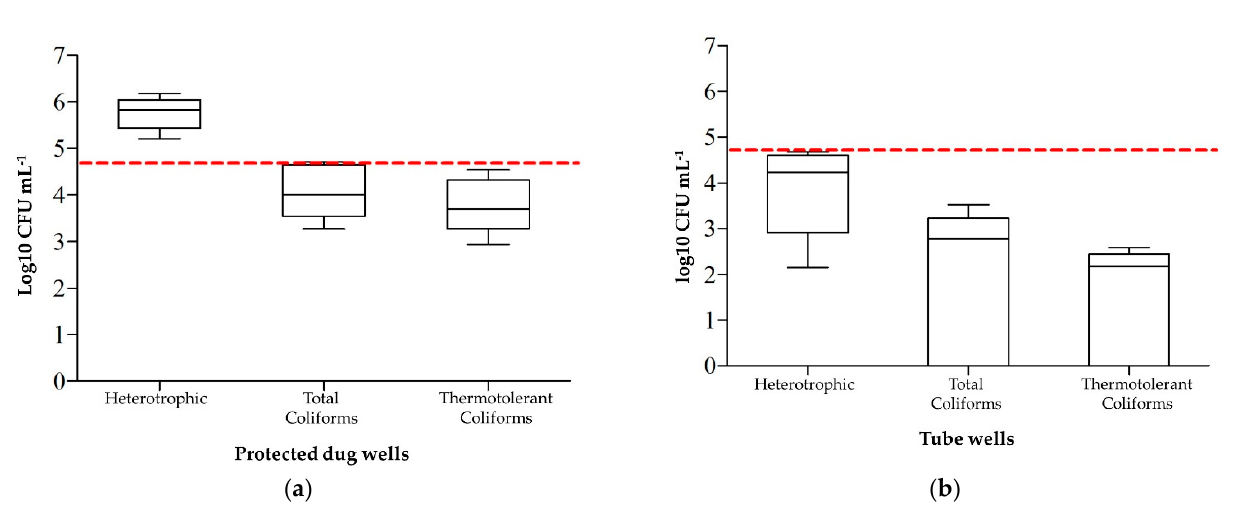
Figure 2. Box-and-whisker plots (min/max, lower/upper quartiles, and median) shown into log10 of the counts of heterotrophic bacteria, total coliforms and thermotolerant coliforms in water samples of the protected dug wells (( a ), n = 5) and tube wells (( b ), n = 5) in Porto Velho. The dashed line represents the limit heterotrophic bacteria indicated by Brazilian regulations.